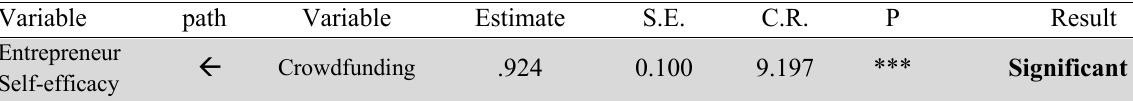
Regression Weight for Path Estimate Variable